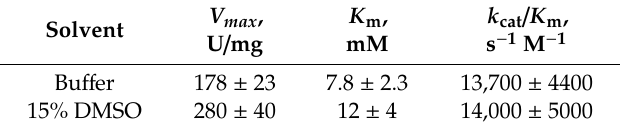
Table 1. Steady-state kinetic parameters of the transamination reaction catalyzed by TaTT at 50 ◦ C.